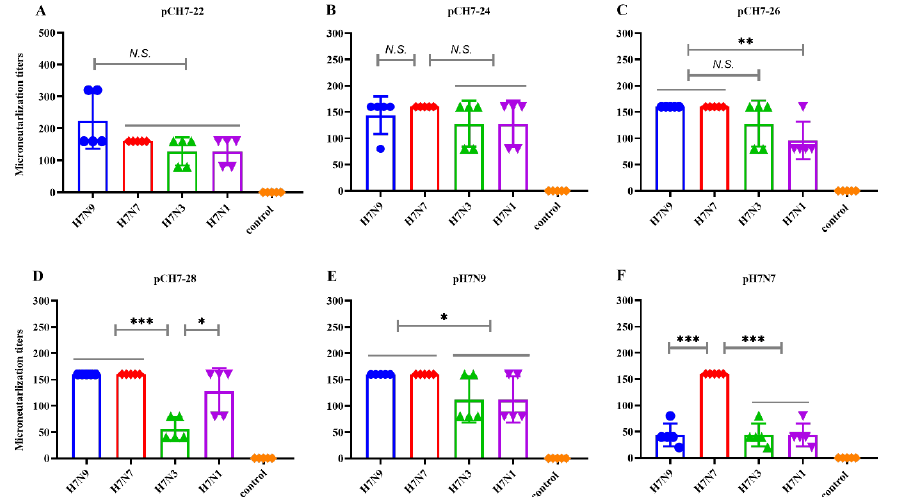
Figure 6. DNA vaccines encoding consensus H7 proteins elicit broad neutralizing antibody responses in mice. Serum treated with a receptor-destroying enzyme (RDE) was diluted from 1:20 to 1:2560 by two-fold serial dilutions in culture medium (DMEM containing 100 U / mL penicillin G, 100 µ g / mL streptomycin, and 0.5 µ g / mL TPCK-treated trypsin). Diluted serum solutions were mixed with culture medium containing 100 TCID 50 H7N9, H7N7, H7N3, and H7N1 at room temperature for 1 h. The virus-serum mix was then applied to MDCK cells. Culture medium was added, and the plates were incubated for 72 h. Endpoints were determined by the hemagglutination titer. Values are the mean titers plus the standard error of the mean (error bars) ( A–F ). Statistical significance was analyzed by t test. P values shown in bar charts and N.S. indicates no significance between two compared groups. * p < 0.05, ** p < 0.01 and *** p < 0.001 between indicated groups.